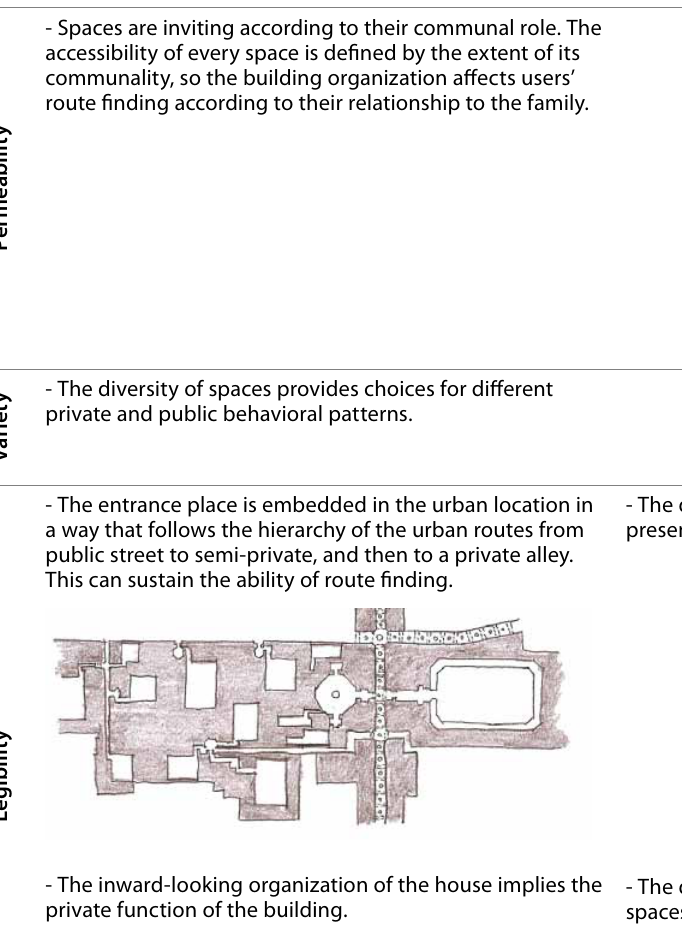
Table 3. responsiveness to social-cultural